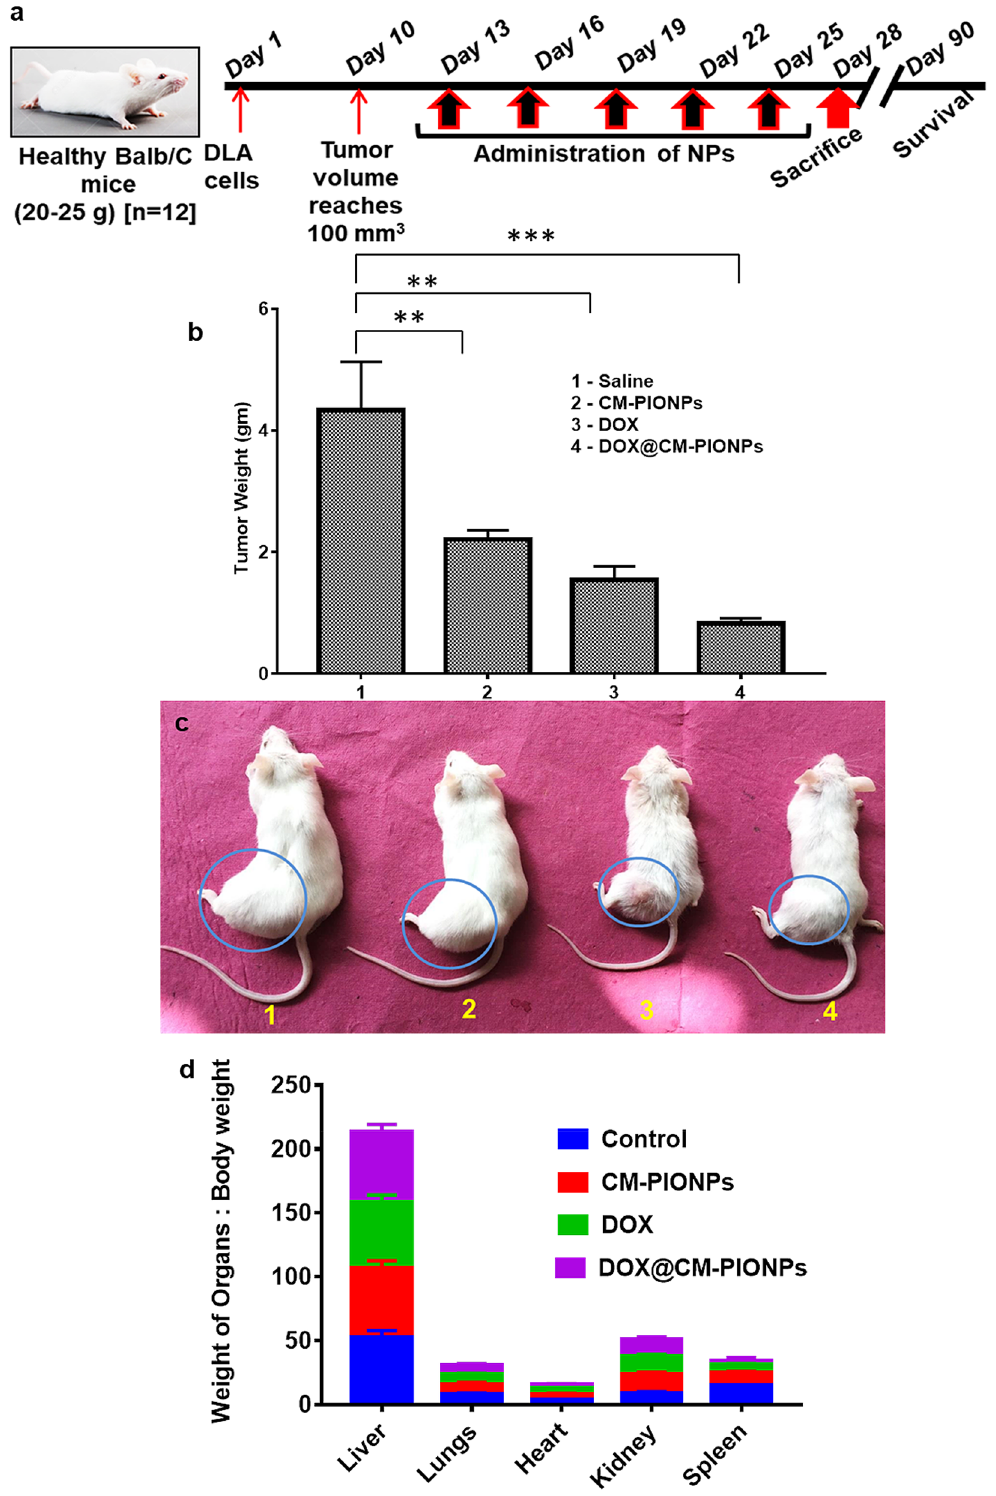
Figure 5. ( a ) Schematic representation of in vivo tumor reduction study. The treatment was started after 10 days of subcutaneous inoculation of DLA cells. The administration of compounds was carried out with an interval of 3 days for 15 days (reprinted from https:// www. criver. com). ( b ) Tumor weight analysis. ( c ) Representative images of mice treated with CM-PIONPs, DOX and DOX@CM-PIONPs; ( d ) Organ- body weight ratio indicates an increased weight of spleen after 15 days of treatment in the control group is significantly found to be reduced in DOX@CM-PIONPs treated